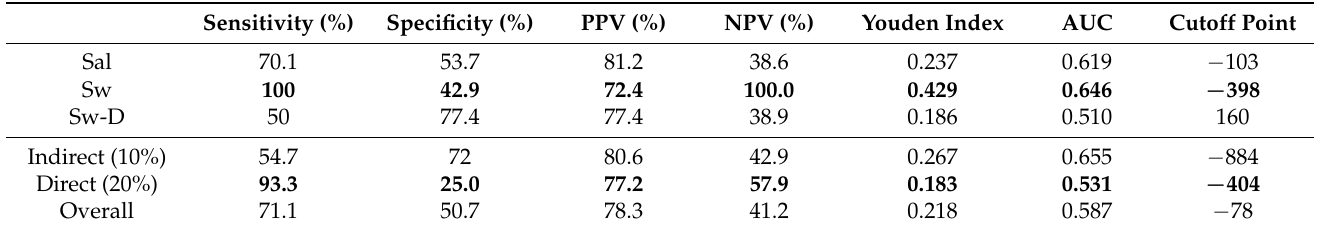
Table 3. Summary of diagnostic accuracy parameters obtained by experimental